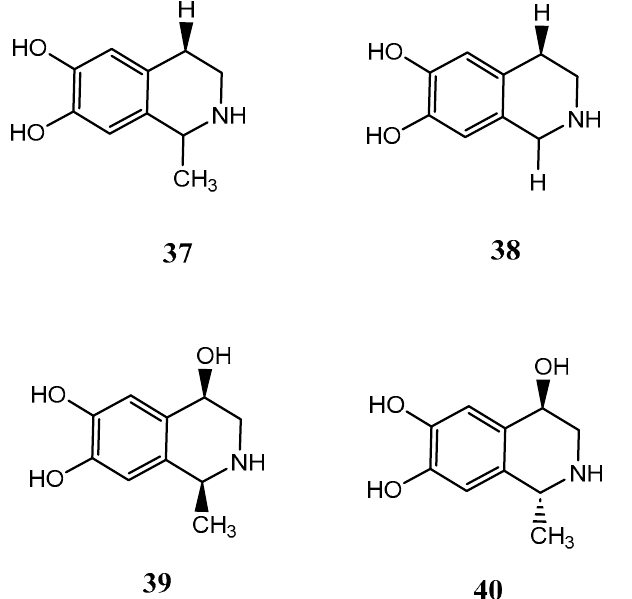
Figure 9. The chemical structures of salsalinol derivatives from Xestospongia vansoesti ( 37 - 40).